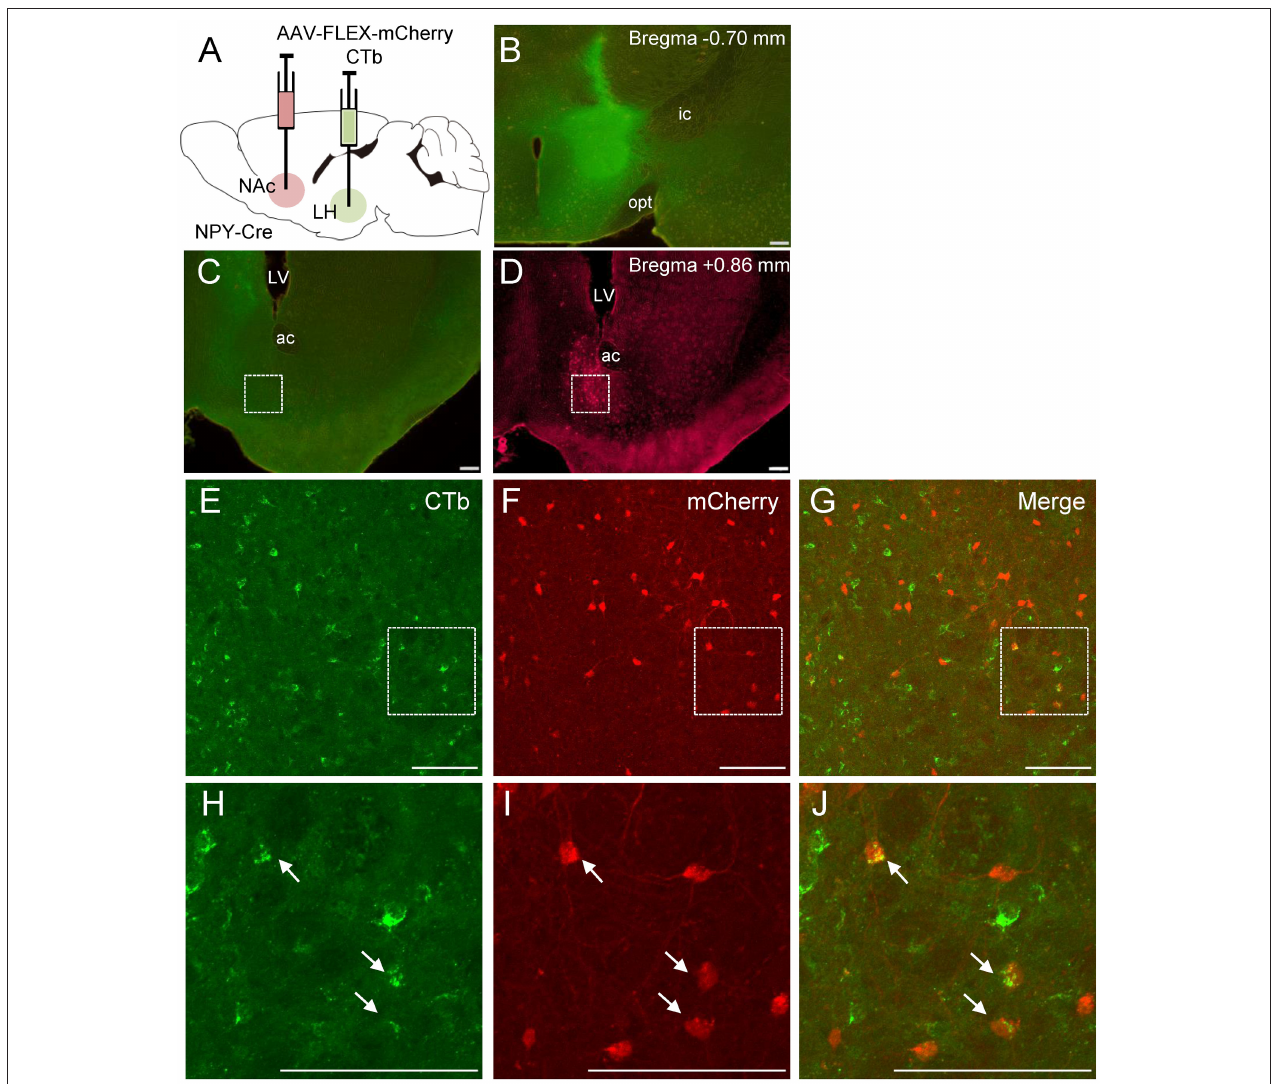
FIGURE 4 | Schematic illustration of AAV(dj)-FLEX-mCherry injection into the NAc and CTb injection into the LH in NPY-Cre mice (A) . Representative photograph of the CTb injection site (B) . Representative photographs showing the site of CTb (C) and mCherry (D) expression in the NAc. Magnified fluorescence image of CTb (E) , mCherry (F) , and merged (G) in the white square box in C and D . The regions in the white square boxes in E , F , and G are more magnified in H, I, and J , respectively. Arrows show CTb and mCherry double-positive neurons. Scale bars, 100 µ m. Numerical values in each photomicrograph show distance from bregma (mm). ac, anterior commissure; f, fornix; ic, internal capsule; LV, lateral ventricle; opt, optic